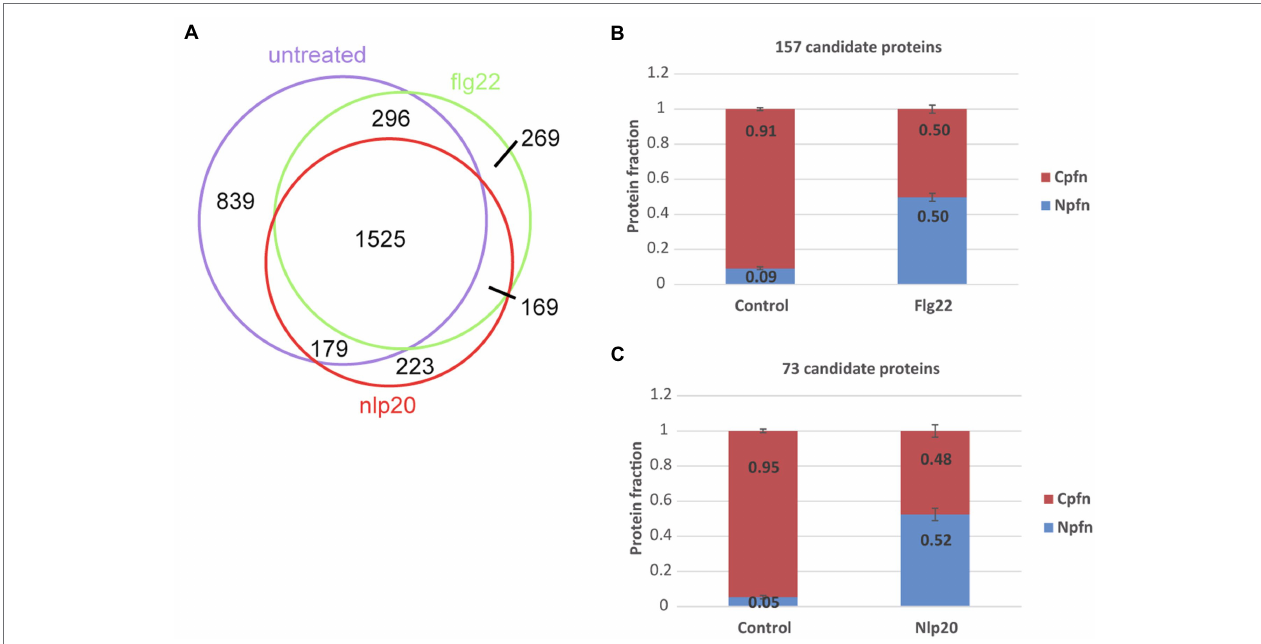
FIGURE 2 | Protein import into the nucleus following elicitation of pattern triggered immunity (PTI). (A) Intersections of curated nuclear protein fractions extracted from untreated and flg22 and nlp20 treated protoplasts. (B) Mean nuclear and cellular protein enrichment scores (Npfn and Cpfn values) of 157 proteins identified in both the nuclear and cellular protein fractions without and following flg22 treatment. Error bars denote standard error. (C) Mean nuclear and cellular protein enrichment scores (Npfn and Cpfn values) of 73 proteins identified in both nuclear and cellular protein fractions without and following nlp20 treatment. Error bars denote